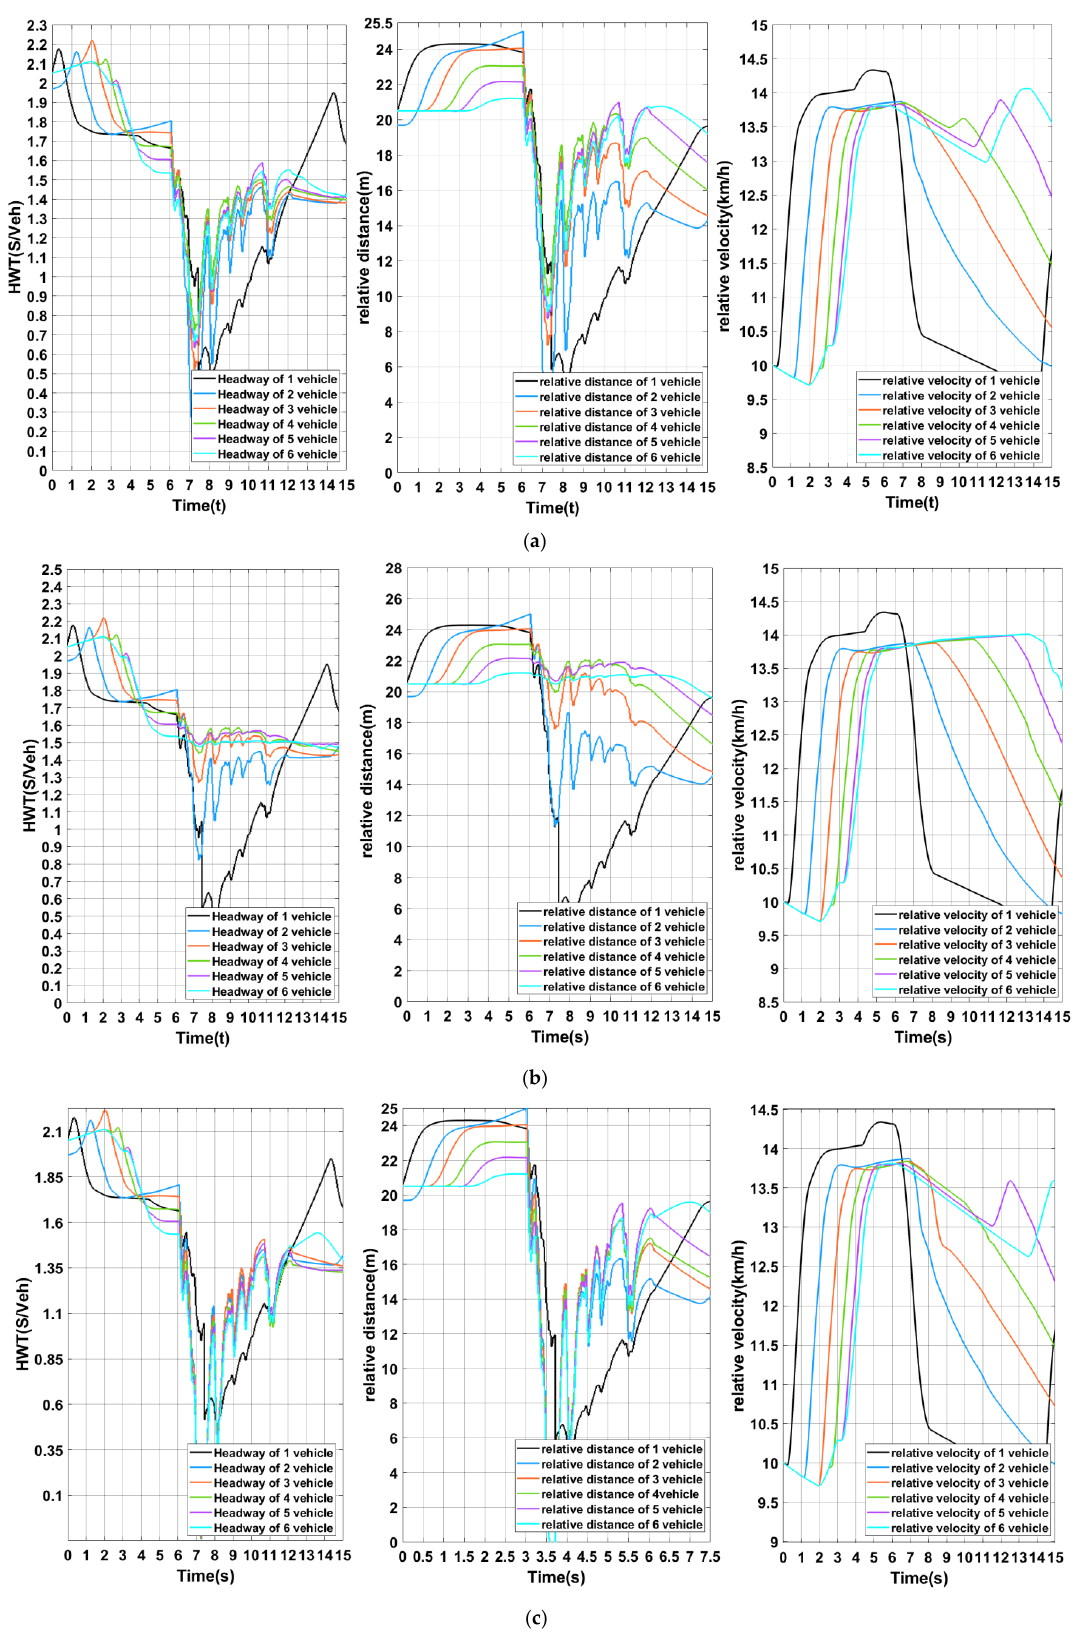
Figure 3. Multi vehicle attenuation factor distributed at a headway/speed/distance: ( a ) factor is 0.5 – 0.9; ( b ) factor is 0.0 – 0.5; ( c ) factor is 1.